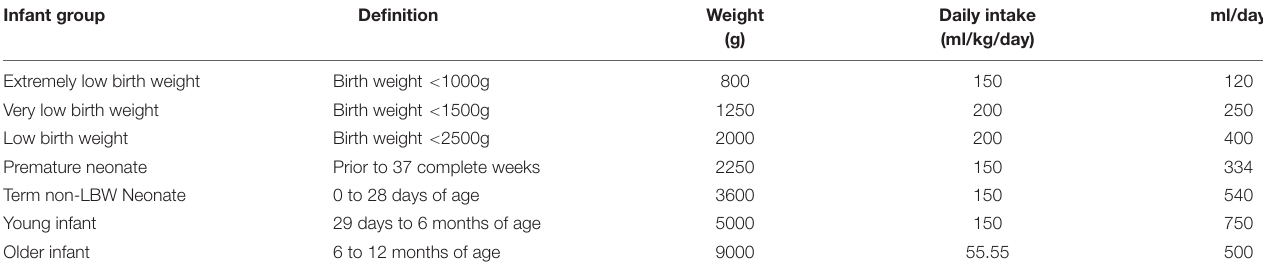
TABLE 1 | Infant group definitions presents as options in the risk assessment model (modified from FAO/WHO, 2006). Infant group